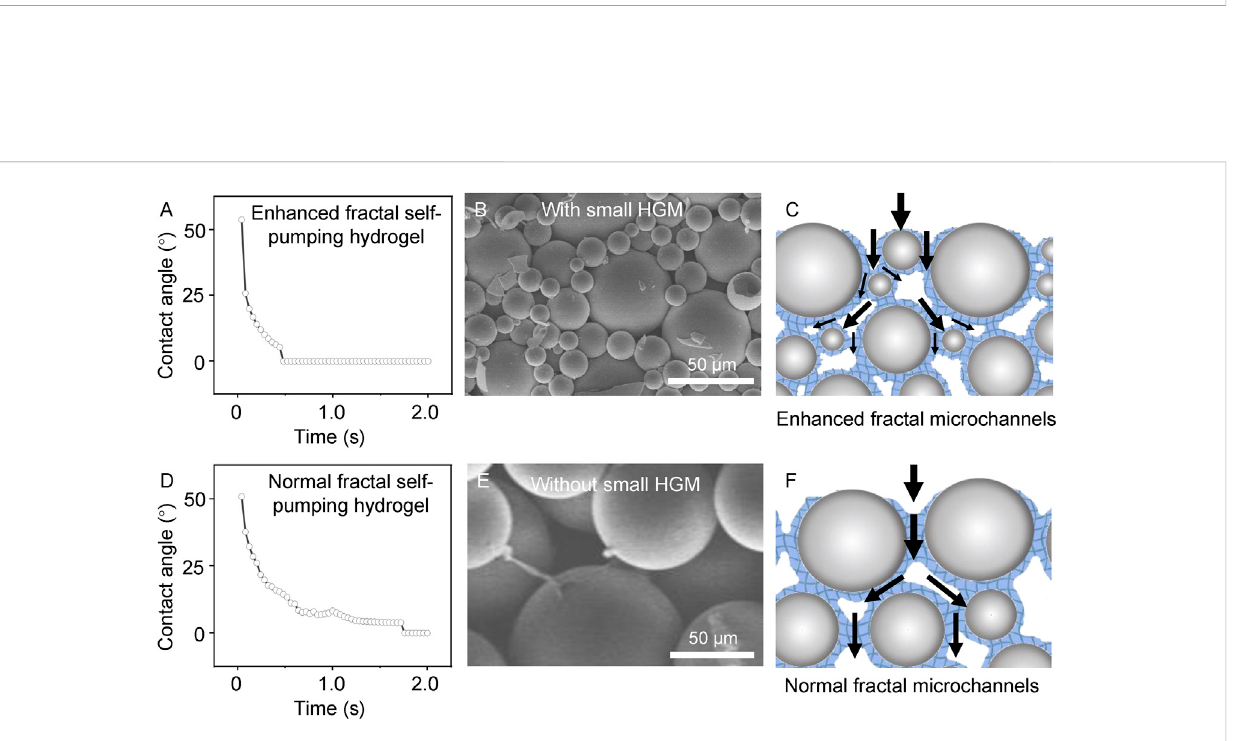
Frontiers in Bioengineering and